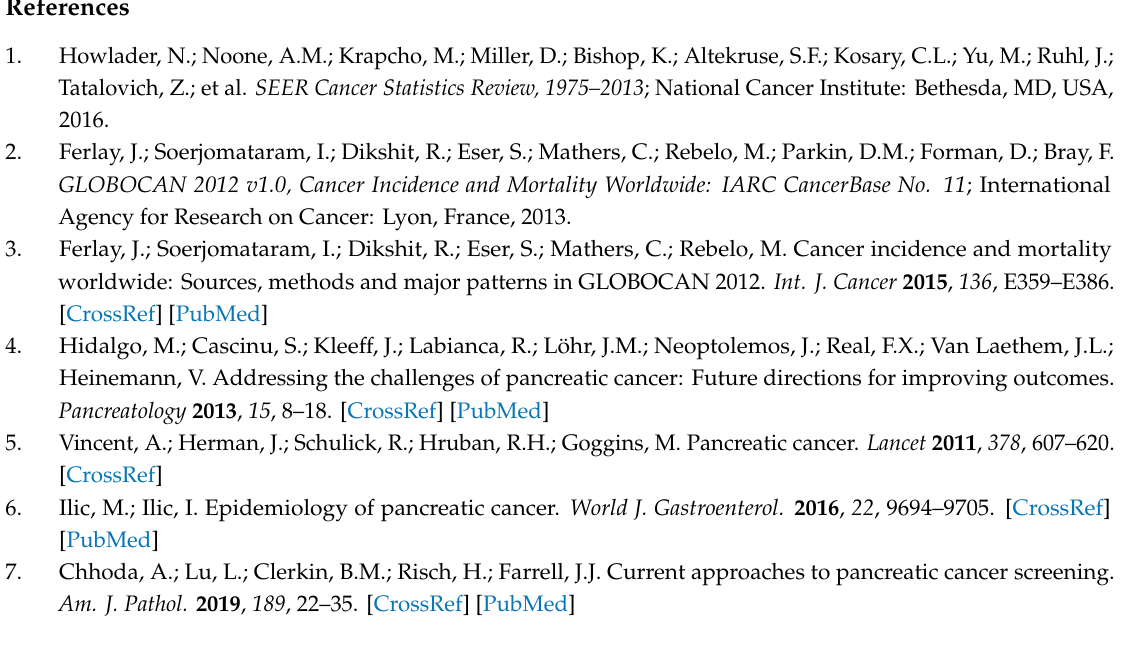
Supplementary Materials: The following are available online, Figure 1: 1 H NMR spectra of DMC (600 MHz, MeOD). Figure 2: 13 C NMR of DCM (125 MHz,